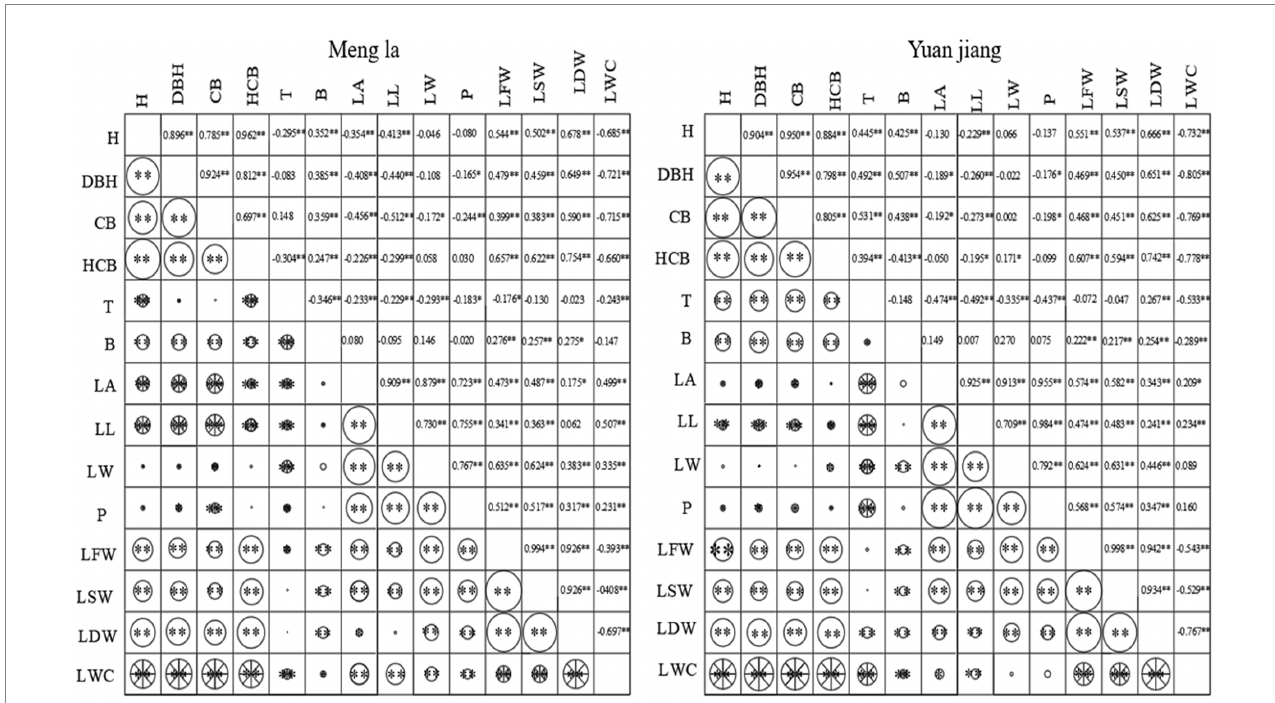
FIGURE 3 Correlation of different growth factors in regard to B. ceiba morphology and structure. Note: * significant level ， p < 0.05 ， ** very significant level ， p < 0.01; Lines mean negative correlation, white circles mean positive correlation, and the size of circles represent the level of